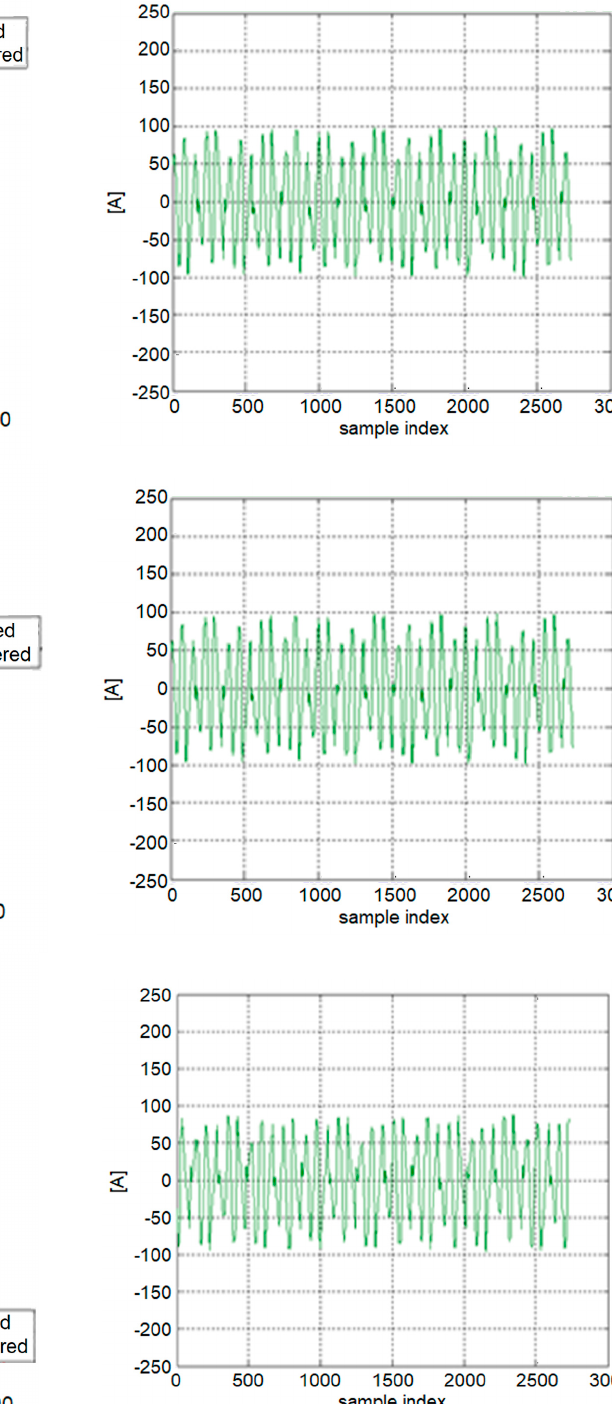
Table 7. E xplanatory with the active filter efficiency evaluation from a technical point of view. PQ Index Computed with FFT, without Compensa ‐